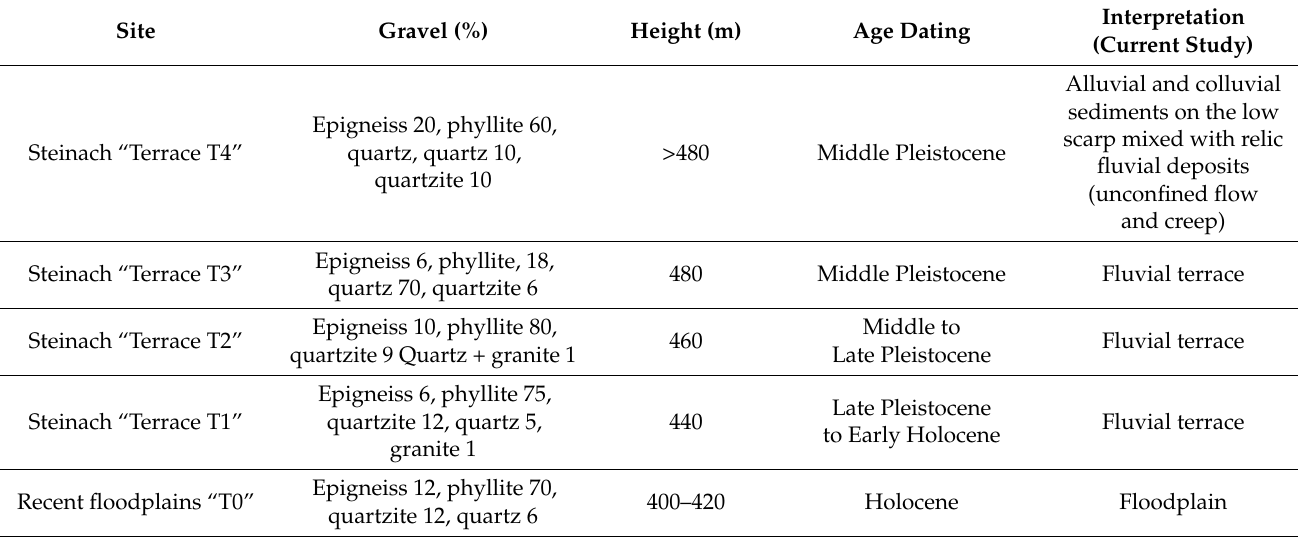
Table 4. Composition of gravel assemblages on different terraces laid down in the foreland (DA) of the Fichtelgebirge (LGG-Type). For locality see Figure 10b.